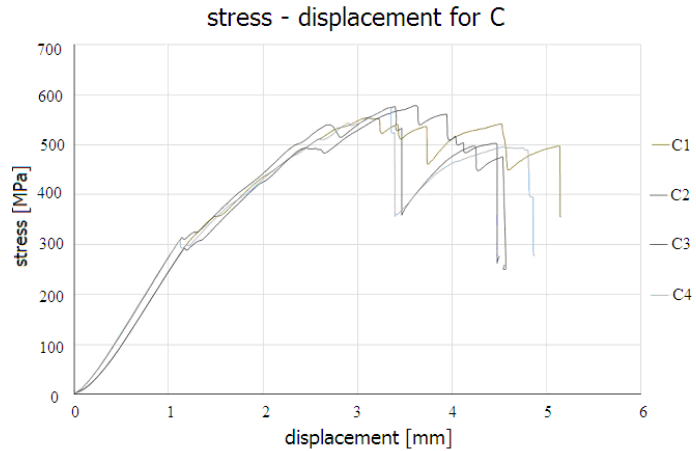
Figure 6. Mechanical characteristics of the 3-point bending test for samples subjected to temperature—group B.